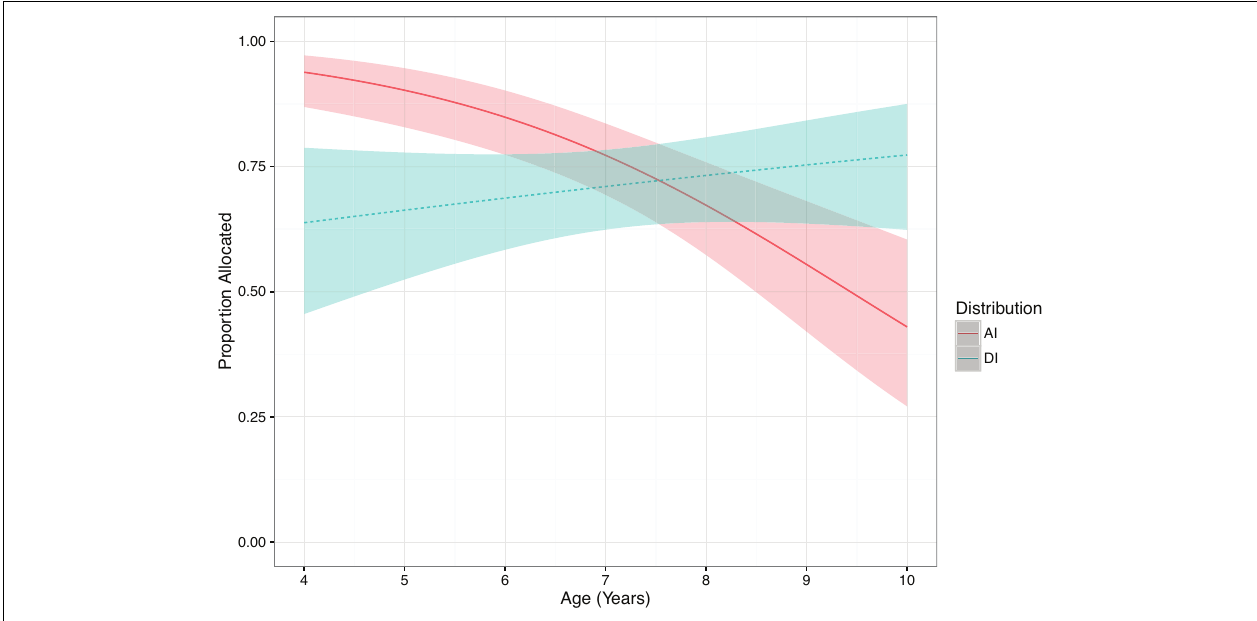
FIGURE 1 | Predicted proportion allocated on Fairness trials by Distribution, plotted over age. Ribbons show 95% confidence intervals.